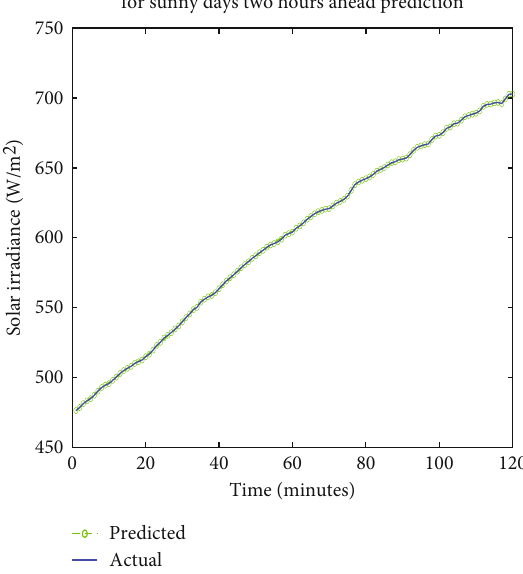
Figure 7: Comparison of predicted solar irradiance and actual solar irradiance for sunny day two-hour-ahead